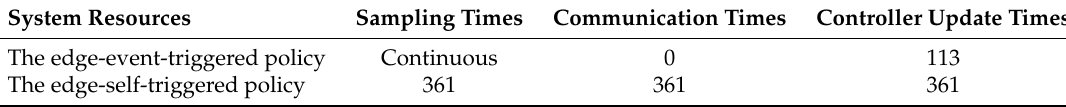
Table 2. Comparisons of the trade-off between different system resources in t ∈ [ 0,10 ]